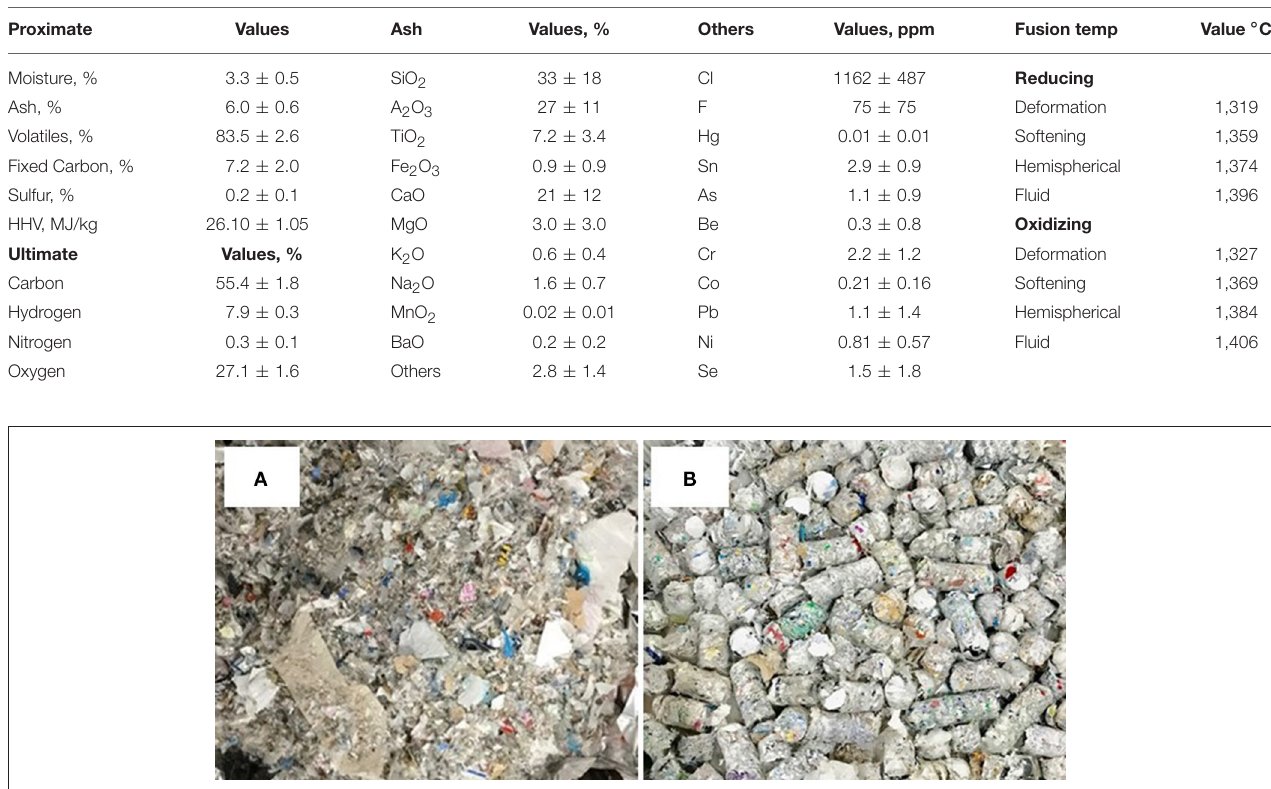
TABLE 2 | Properties of CE material averaged over a 7-year period. Proximate Values Ash Values, % Others Values, ppm Fusion temp Value ◦ C Moisture,